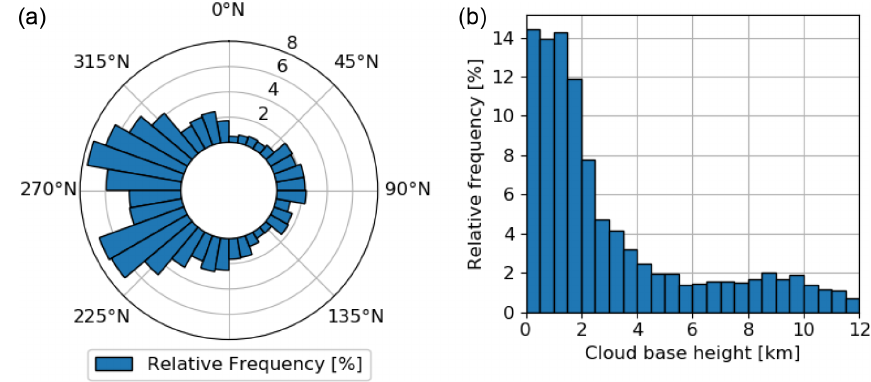
Figure 4. Wind rose of cloud motion directions derived from ASI UOL, indicating a dominance of clouds coming from western directions (a) , and the distribution of the cloud base height (CBH) in the analyzed period (b) .